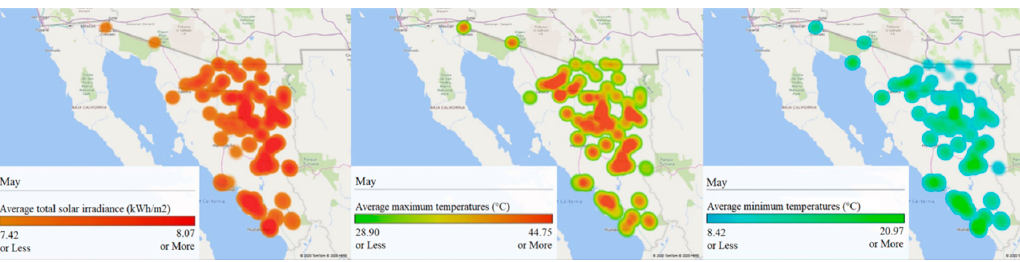
Figure 10. GIS analysis of Sonora for April: ( left ) average total solar irradiance (kWh/m 2 ), ( center ) maximum average temperatures (°C), and ( right ) minimum average temperatures (°C).